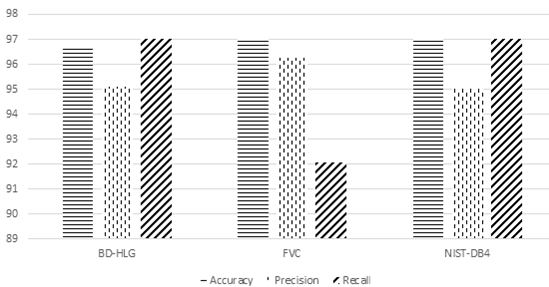
Figure 10. Result of classification using Random Forest algorithm of 3 databases.